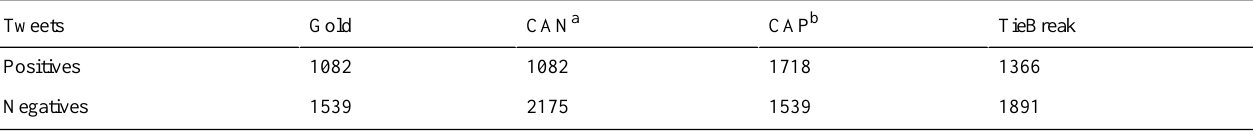
Table 6. Class distribution of tweets in the datasets.